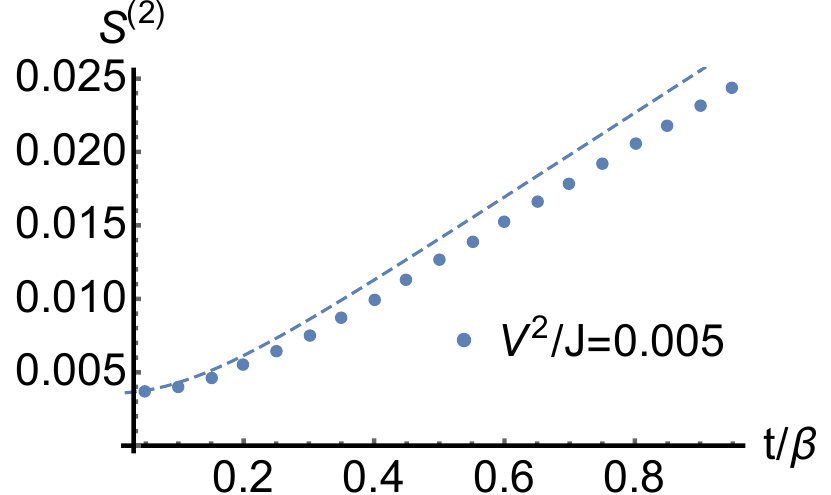
Figure 4. Comparison of the analytic formula (B.2) with numerics for V 2 =J = 0 : 005, (cid:12)J = 4 and (cid:3) = 5 J